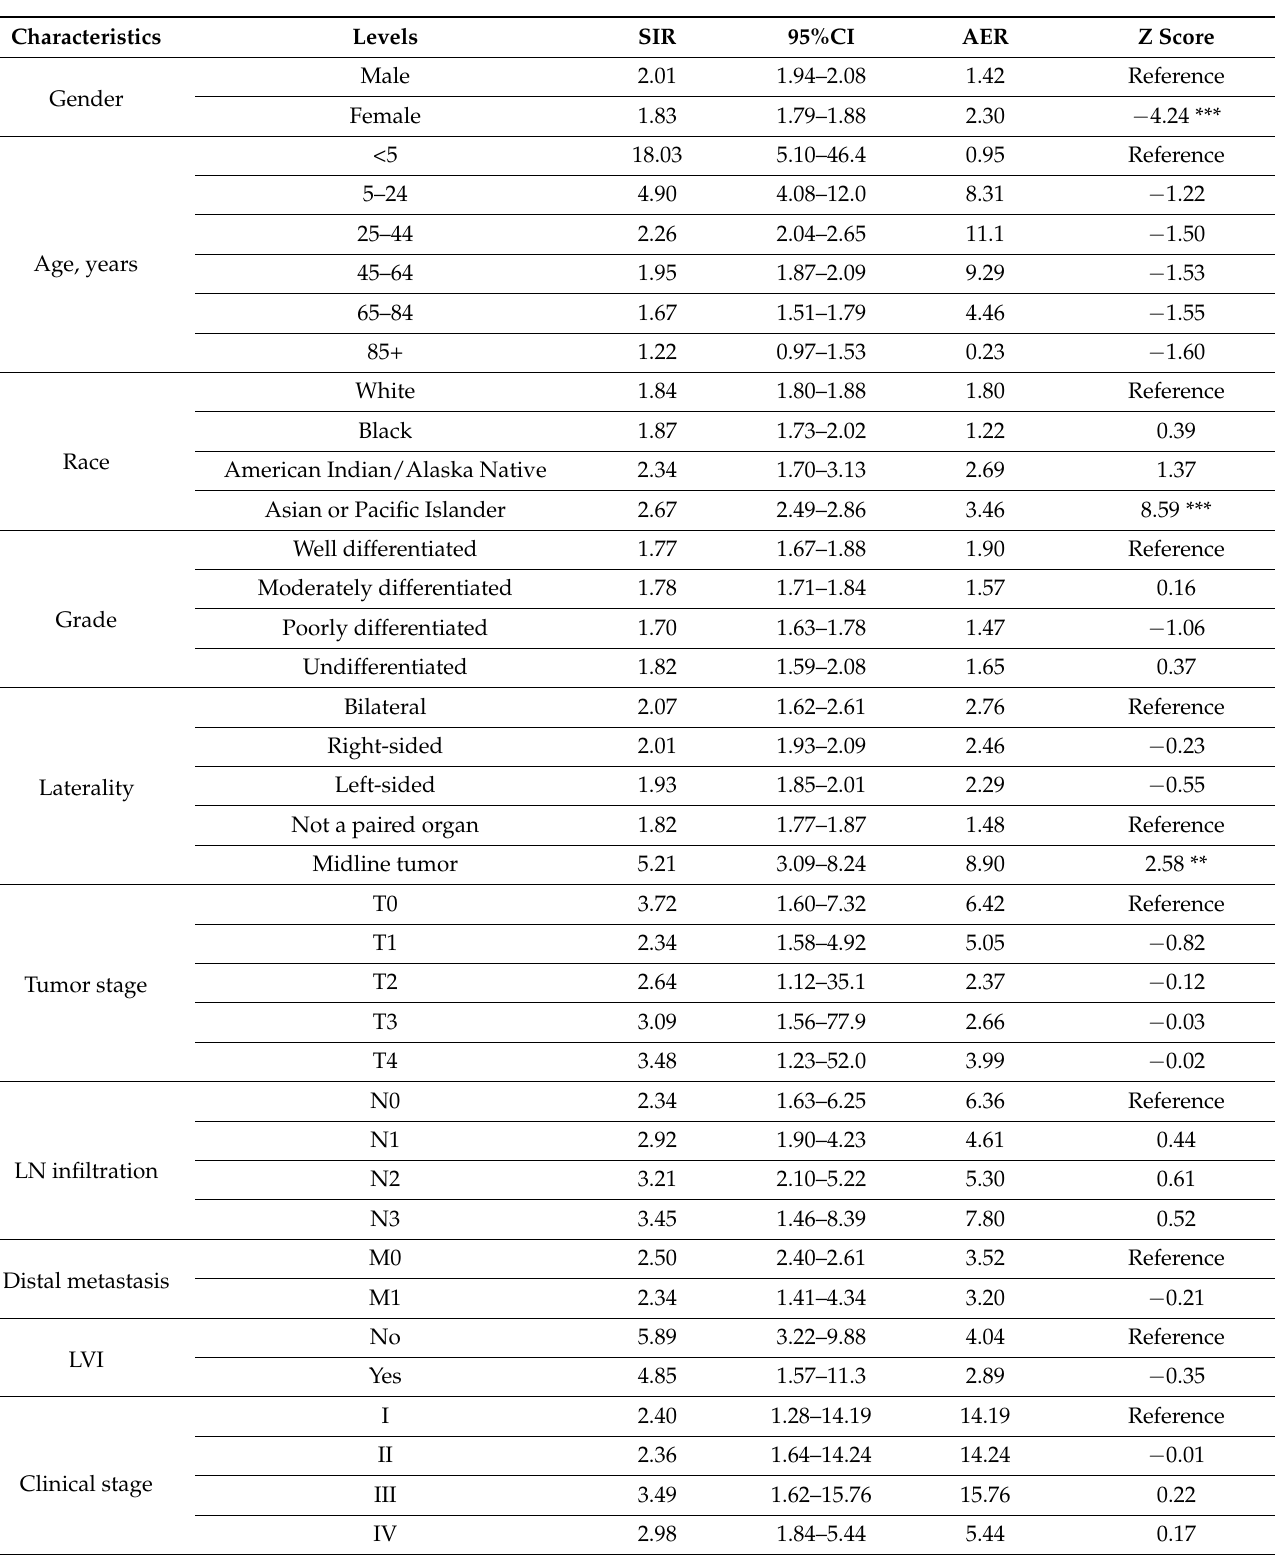
Table 2. Risk of SPTC after another malignancy, stratified by patient characteristics at the diagnosis of primary